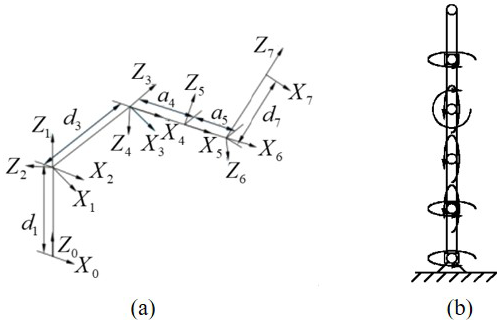
Figure 4. (a) Cartesian coordinate system of Cyton Gamma 300. (b) Joint rotation direction of Cyton Gamma